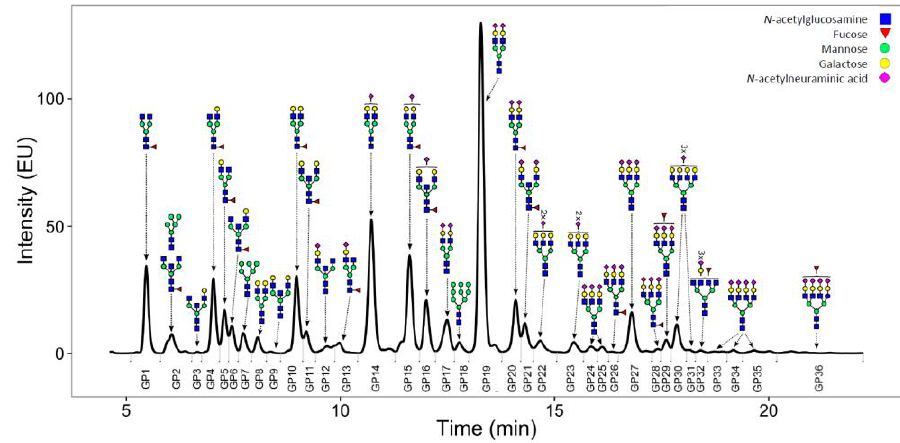
Figure 4. Representative chromatogram of a total plasma N-glycome. Fluorescently labelled plasma N-glycans were separated by HILIC-UPLC into 36 peaks (GP1–GP36). The glycan content in each peak was assigned as determined previously [38]. The amount of glycan species in each peak was expressed as % of total integrated area.